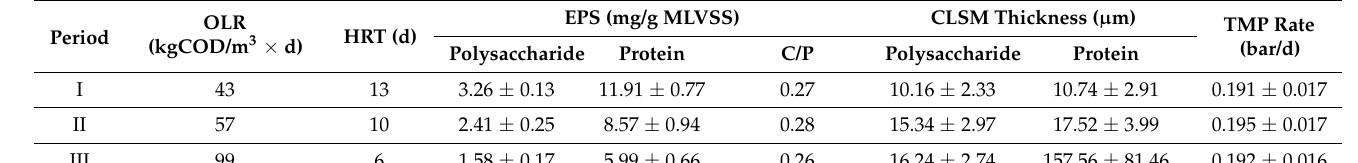
Table 2. EPS substances and fouling parameters evaluated for each OLR.